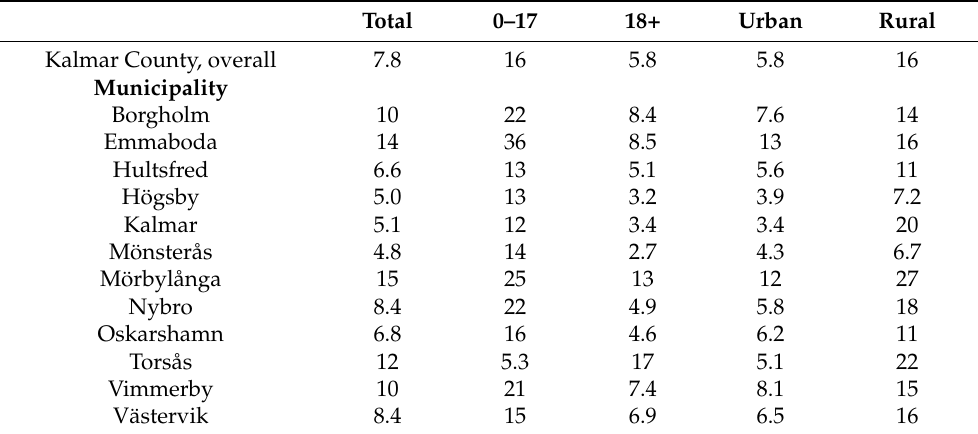
Table 3. Average annual LNB incidence per 100,000 inhabitants, overall and by municipality for the period